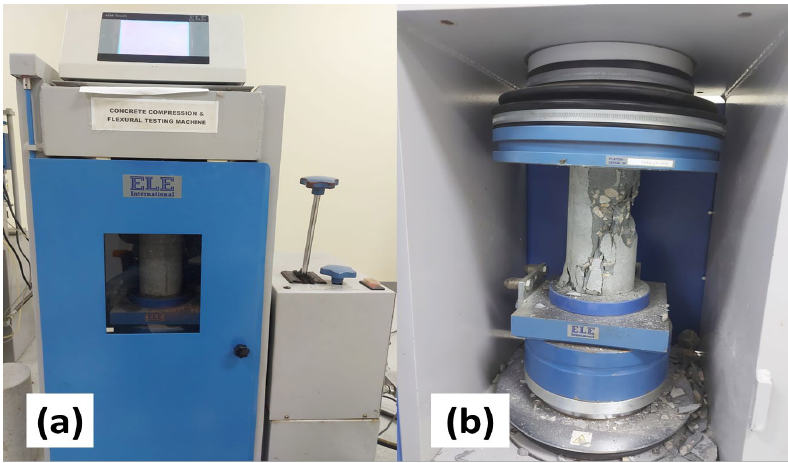
Figure 2. ( a ) Compressive Testing machine ( b ) Crushed cylindrical specimen.